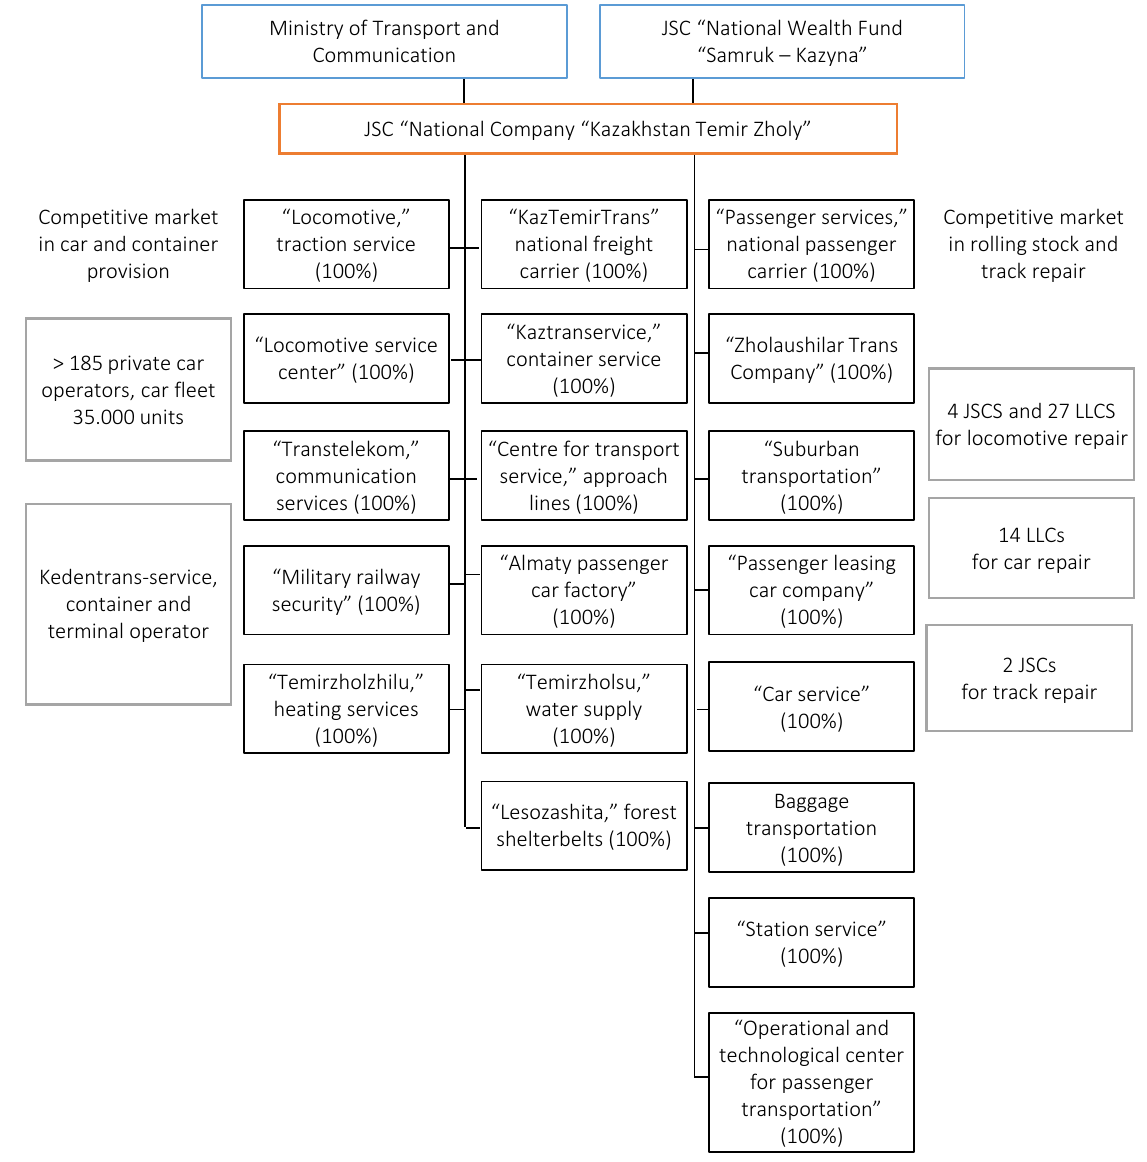
Figure 2. National Railway Company Kazakhstan’s corporate